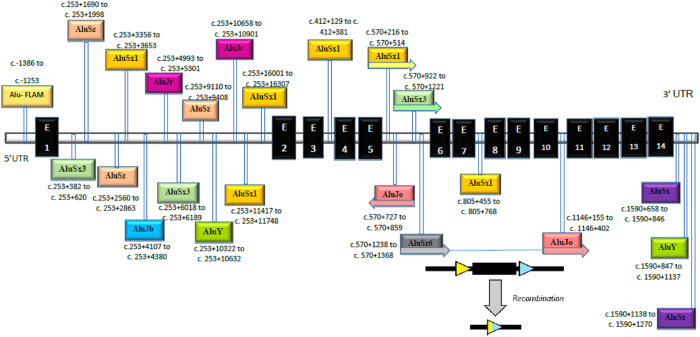
Different Alu elements across the HEXA gene. The most prevalent Alu element across this gene are the AluS class, mainly AluSx. As seen, the possible mechanism for the deletion of exons 6–10 is recombination between AluSz6 in intron 5 and AluJo in intron 10.